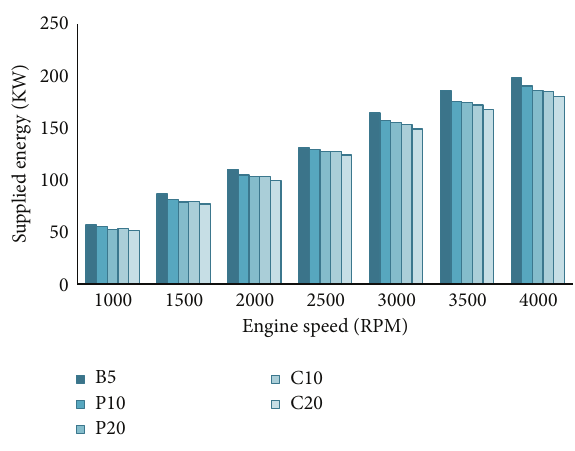
Figure 9: Supplied fuel energy variation.